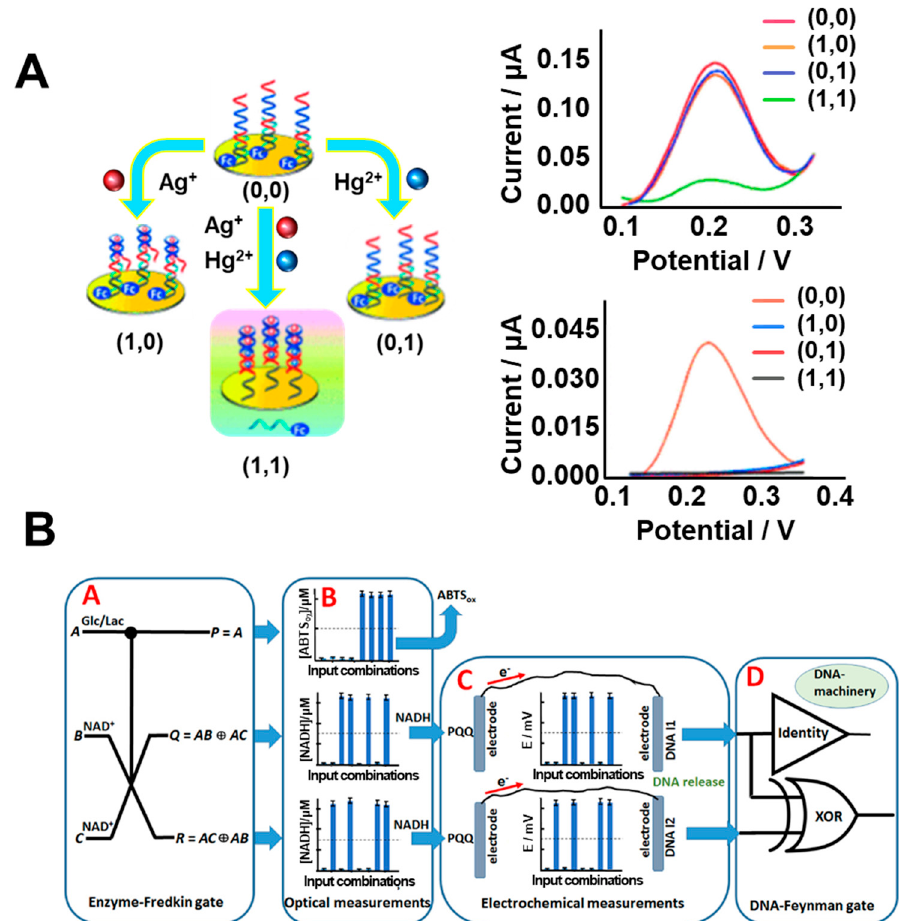
Figure 5. Biologic gates. ( A ) Schematic image of a DNA-based biologic gate based on metal ions inserted inside mismatched DNA pairs and differential pulse voltammetry (DPV) results of this device by controlling output signals through Ag + and Hg 2+ ions inserted inside mismatched DNA pairs. ( B ) Schematic image of a protein/DNA-based biologic gate through the signal transduction of a protein-based biologic gate to a DNA-based biologic gate for the final outputted fluorescence signal (Reproduced with permission from [64], published by John Wiley and Sons, 2013 and reproduced with permission from [65], published by John Wiley and Sons, 2016).